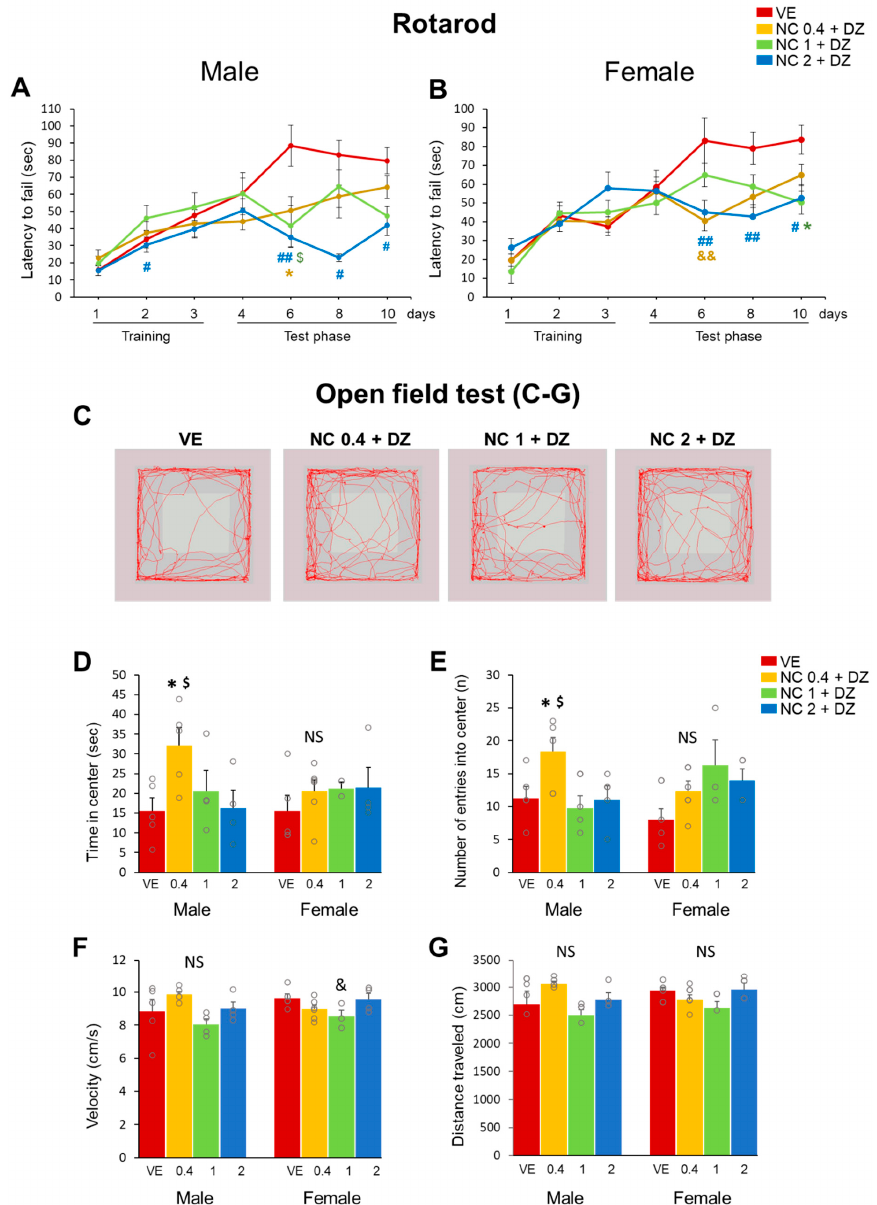
Figure 2. Combined exposure to nicotine and diazinon impaired locomotor activity in male and female mice. ( A ), rotarod test for male mice, the latency to fall during test phases decreased in male treated group compared to VE. NC0.4 + DZ (day